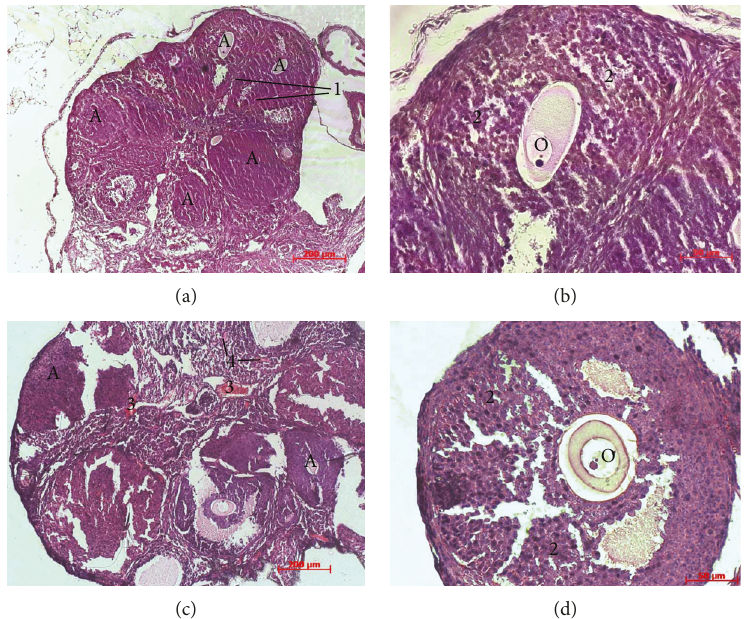
Figure 4: Histological sections of the ovaries on the 10th day of experiment. (a), (b) After saline administration: Ovarian follicle atresia (A) was occurred by productive type and characterized by deformed contour (1) and formation of multilayer capsule from granulosa cells (2), which were compressed, separated, and were less adjacent to oocyte (O). The layers of granulosa cells. (c), (d) After cMSC administration: The number of atretic follicles and severity of productive processes in them decreased compare to the control and the full-blooded capillaries (3), and hemorrhages (4) were determined in the stroma. Hematoxylin and eosin